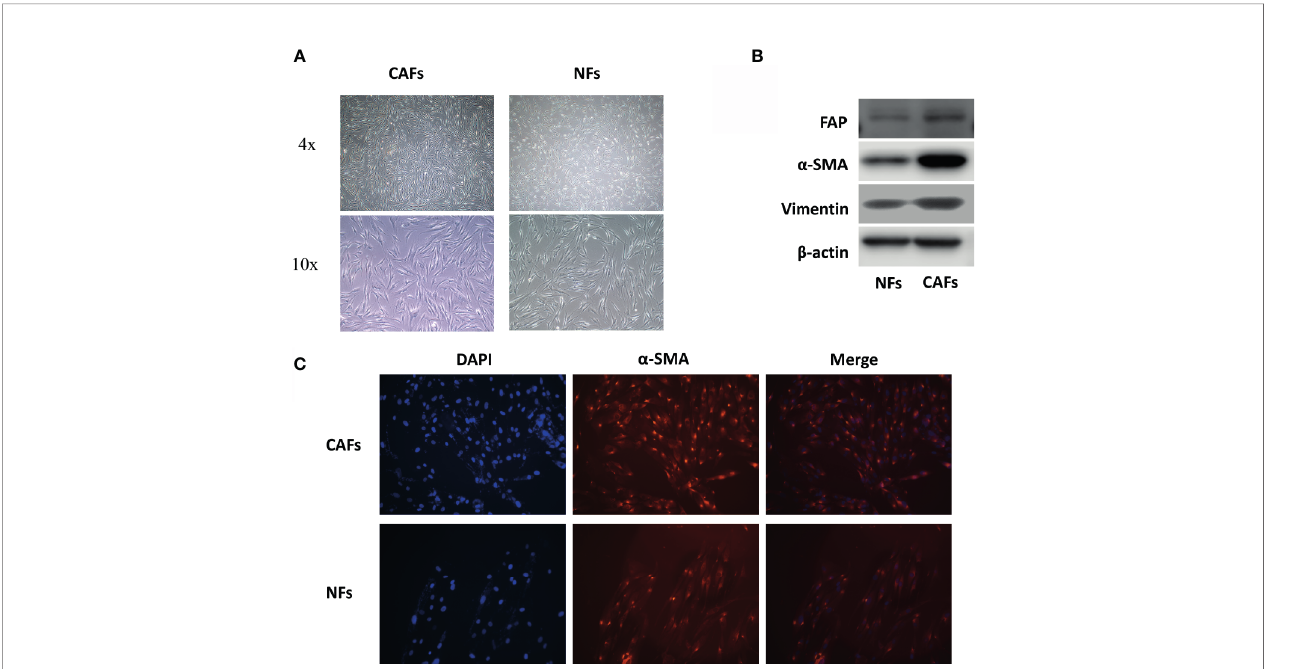
FIGURE 1 | CAFs and NFs were extracted from the tissues of 7 OSCC patients. (A) The morphology of CAFs and NFs. (B) The results of western blotting of a -SMA, FAP, and vimentin in CAFs and NFs. (C) The results of cellular immuno fl uorescence experiments of a -SMA in CAFs and